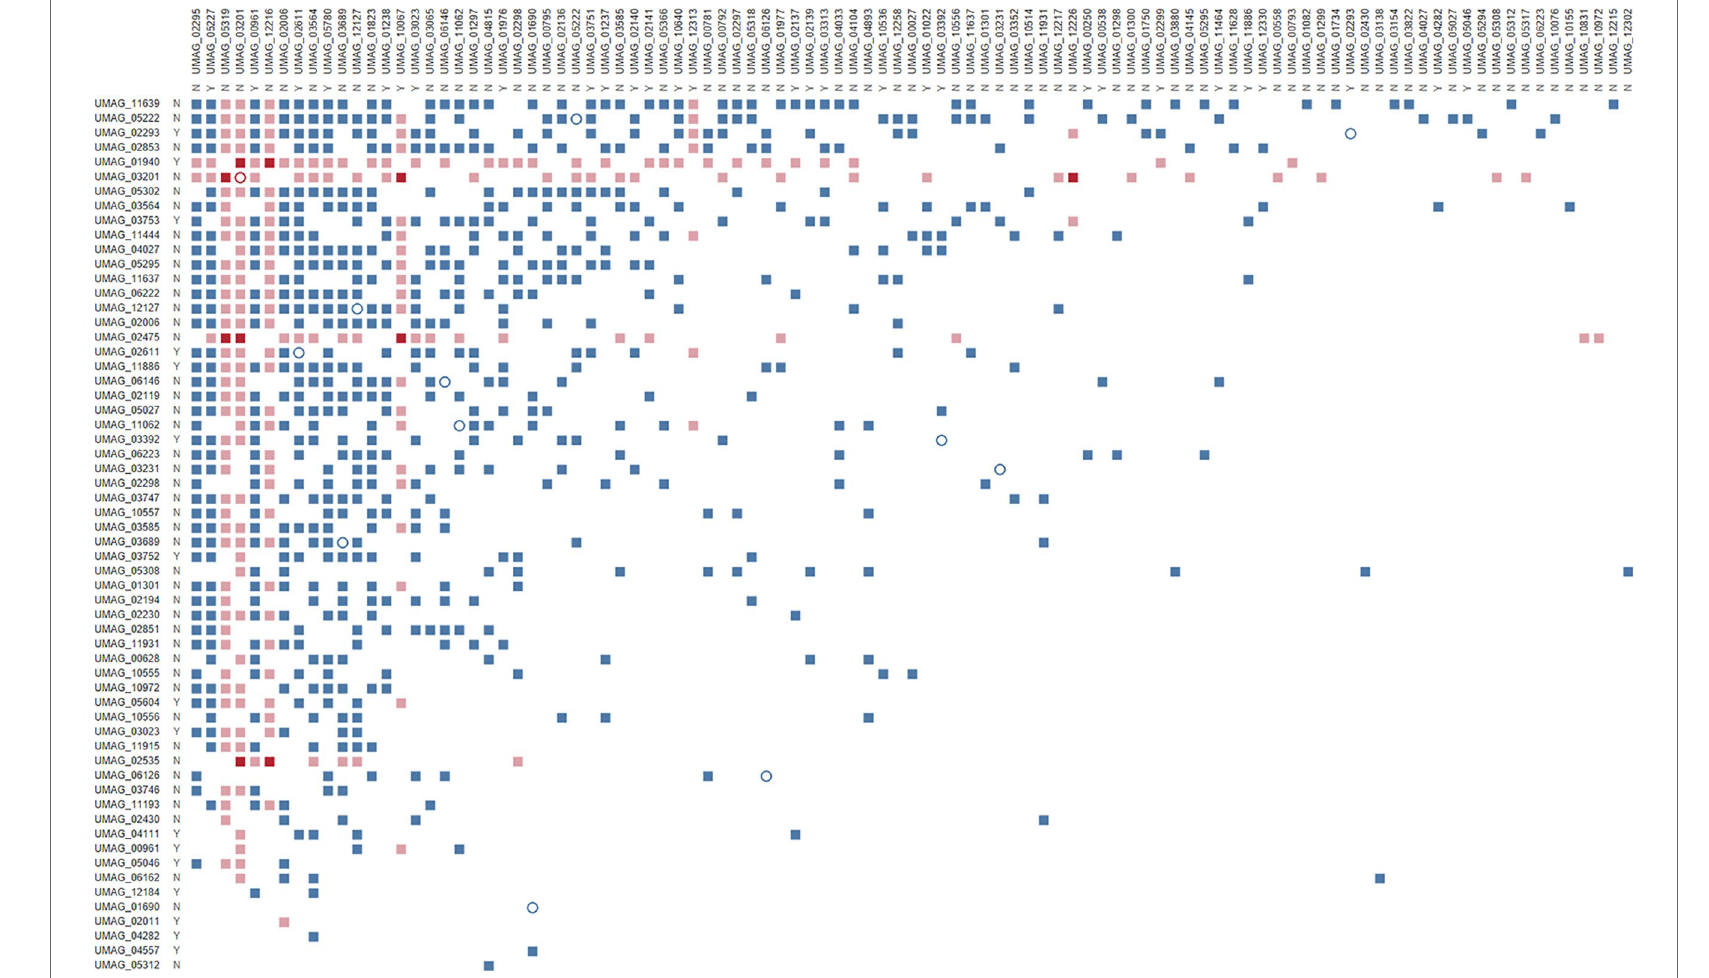
FigURE 1 | Effector–effector interactome of U. maydis confirmed by three independent Y2H replicates. Bait N-terminal Gal4 DNA binding domain (BD) fusions with putative effectors are listed on the left, while prey N-terminal Gal4 activation domain–effector fusions are on the top. Both axes are ordered by decreasing number of interactions. Letters indicate whether proteins are core (Y) or non-core (N) effectors (Schuster et al., 2018); full squares represent heterodimers, while empty circles show homodimers; colors represent effectors that show virulence defects upon deletion in either both (red), one (pink), or none (blue) of the effector pairs (Uhse et al.,